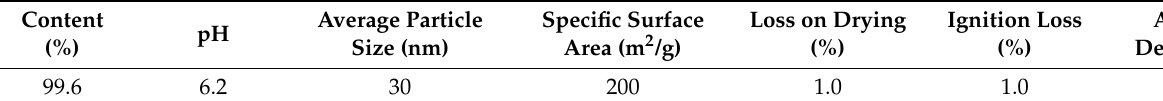
Table 6. Properties of NS.